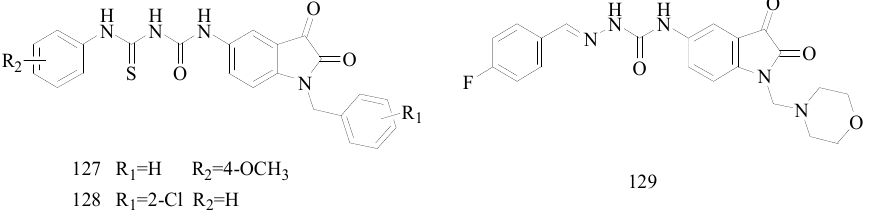
Figure 10. Structures of compounds 127 – 129 .